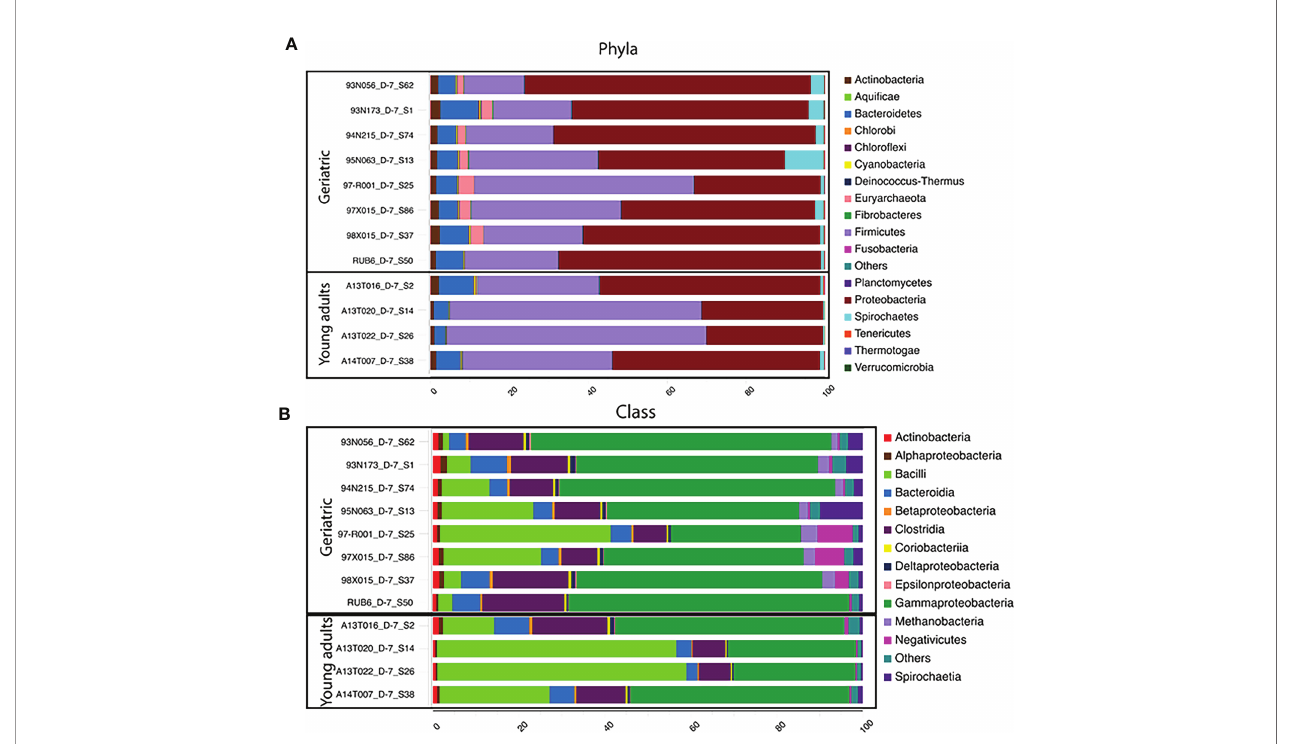
FIGURE 3 | Phylum and Class-level differences in microbiota compositions with age: Stacked bar-plot representation of the percent distribution of microbiota compositions for each animals with taxonomic features at the level of phyla (A) , and Class (B) . The phyla, and class with low relative abundance are grouped as other. At the phylum level, Rhesus gut microbiome is Proteobacteria and Firmicutes dominated, followed by phylum Bacteroidetes. At the class level, classes belonging to Proteobacteria (Gammaproteobacteria) and Firmicutes (Bacilli, negetivicutes) dominates the